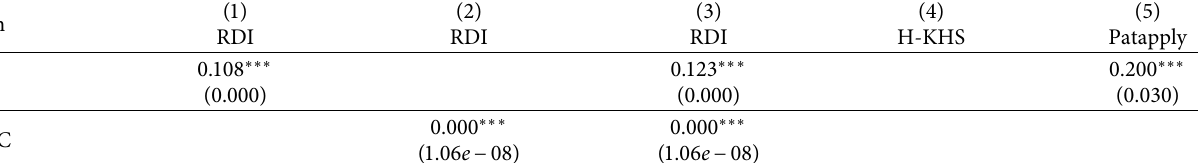
Table 7: Robustness check results.